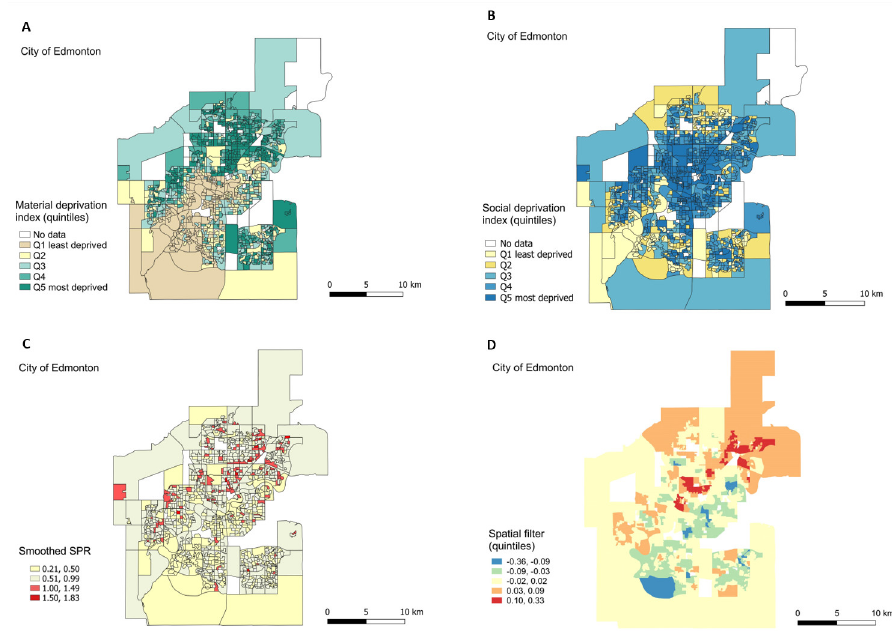
Figure 4. Edmonton maps. Geographic distribution of material ( A ) and social deprivation ( B ) quintiles, smoothed SPR ( C ), and spatial filter ( D ). Quartiles and quintiles split according to rank values for ( C , D ),